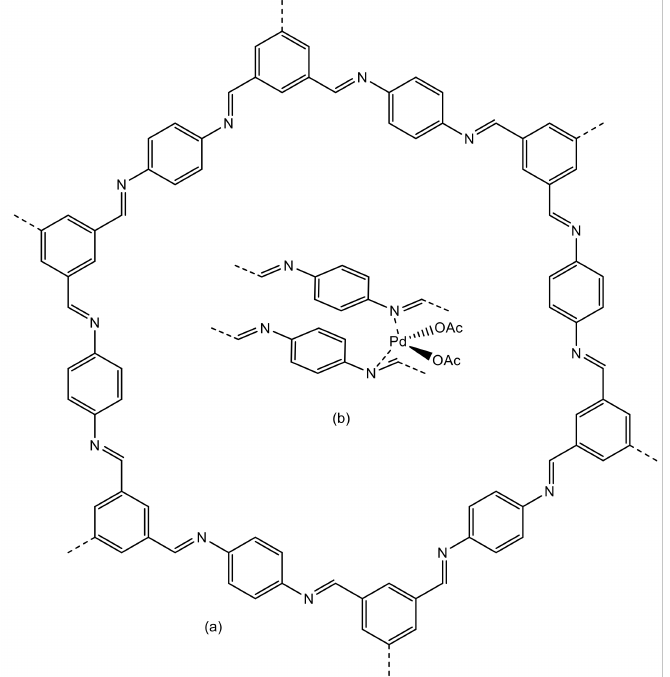
Figure 13. ( a ) Structure of COF-LZU1 and ( b ) schematic representation of bilayer Pd(OAc) 2